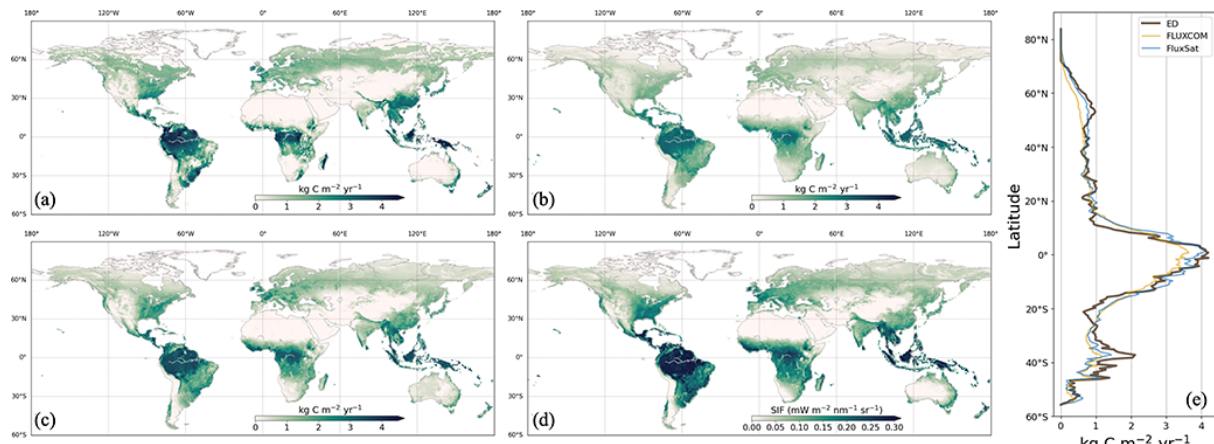
Figure 6. Average annual GPP between 2001 and 2016 from ED (a) , FLUXCOM (b) , FluxSat (c) and the CSIF (d) . A comparison of the latitudinal average GPP values is shown in (e) .